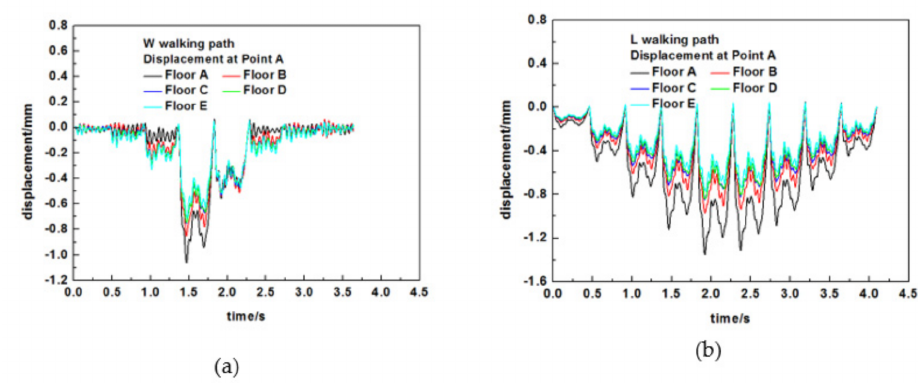
Figure 23. Displacement responses at points A for tested floors: ( a ) W path and ( b ) L